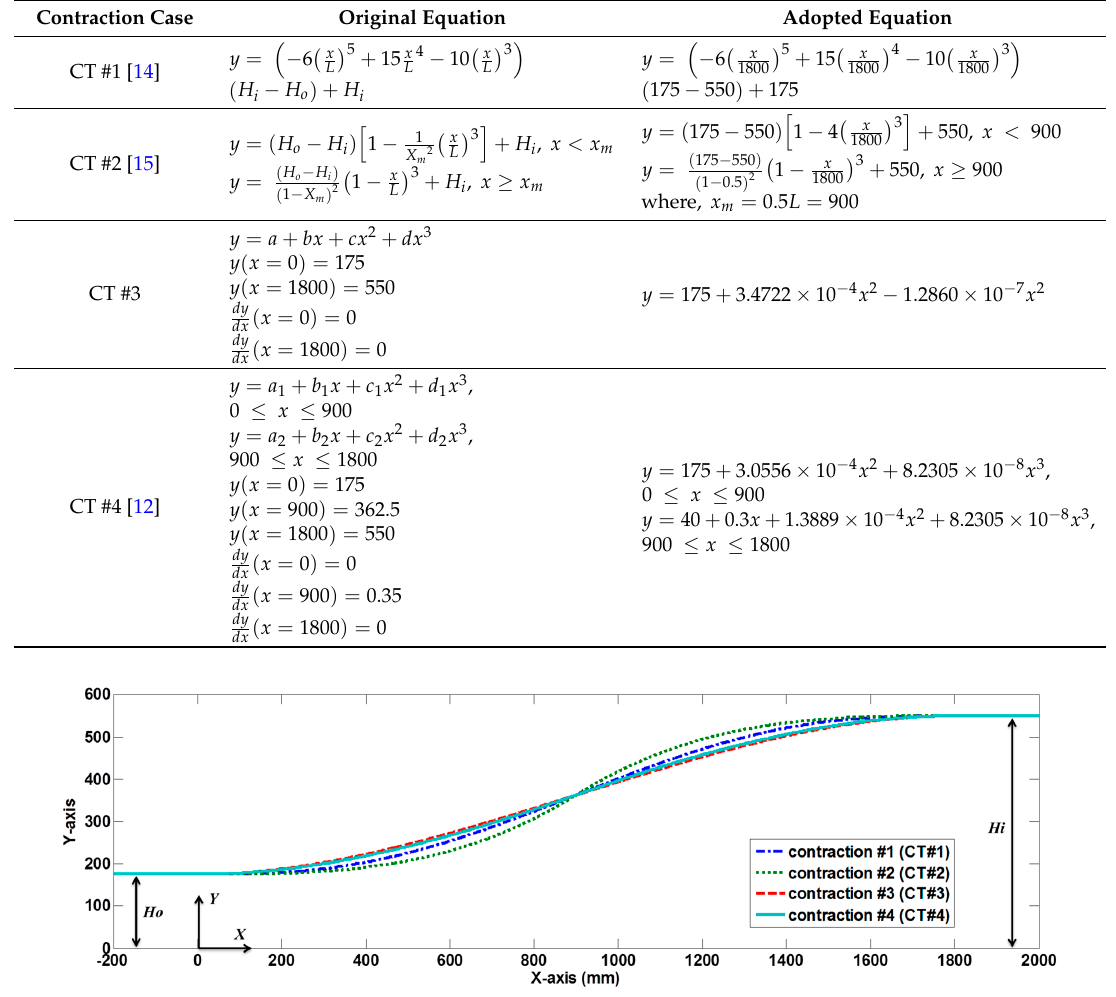
Table 1. Equations for four investigated contraction (CT) wall shapes.